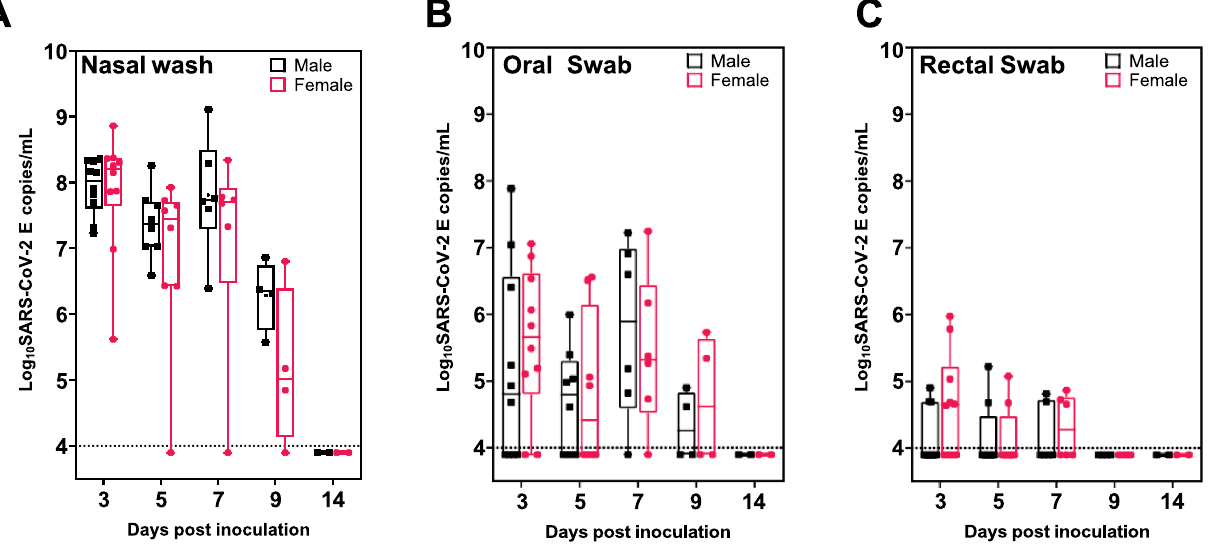
Figure 2. Shedding of SARS-CoV-2 in ferret secretions following intranasal exposure. Virus excretion from ( A ) nasal wash, ( B ) oral swab, and ( C ) rectal swabs at 3, 5, 7, 9, and 14 days post-administration of SARS-CoV-2 as detected by qRT-PCR. Individual data points are plotted, together with box plots show- ing the median values with the whiskers indicating the maximum and minimum viral genome copies/mL. Male data is shown in black and female data in rose. The horizontal dotted line in each panel represents the lower limit of